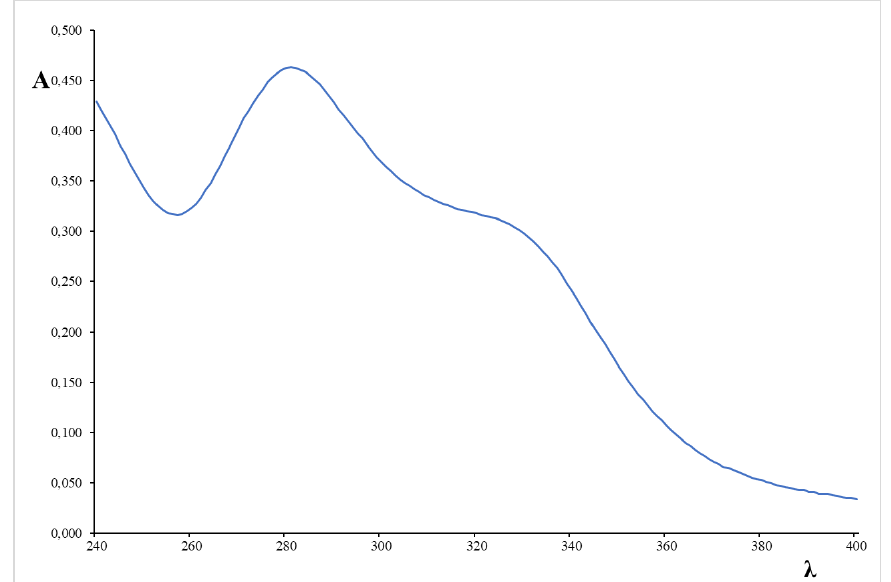
Fig. 6 Absorption spectrum of the original extract of Arctostaphylos uva-ursi